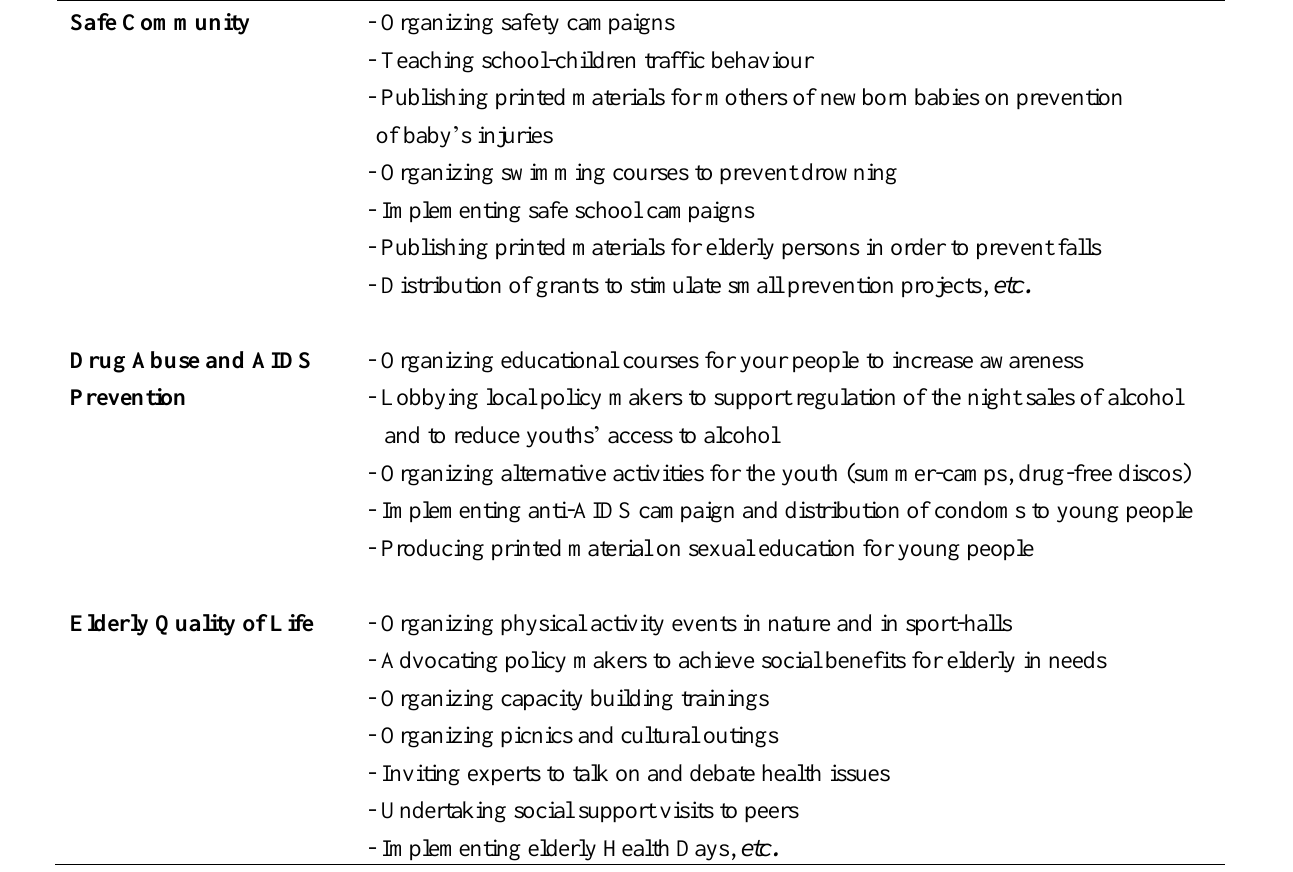
Table 4. Issue-specific processes: some activities undertaken by community workgroups. Community